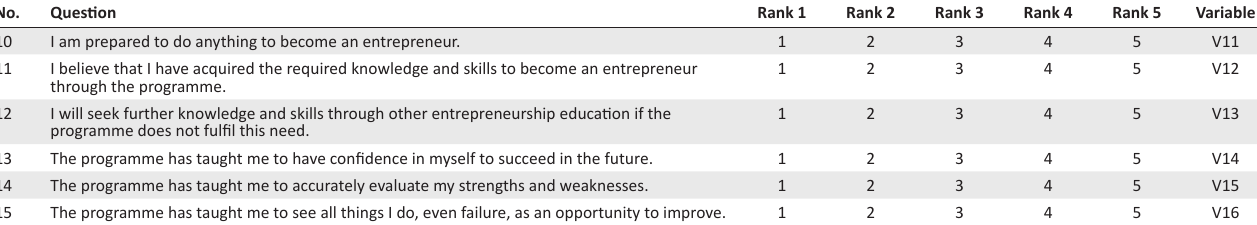
TABLE 6: Questions relating to self-efficacy. No.